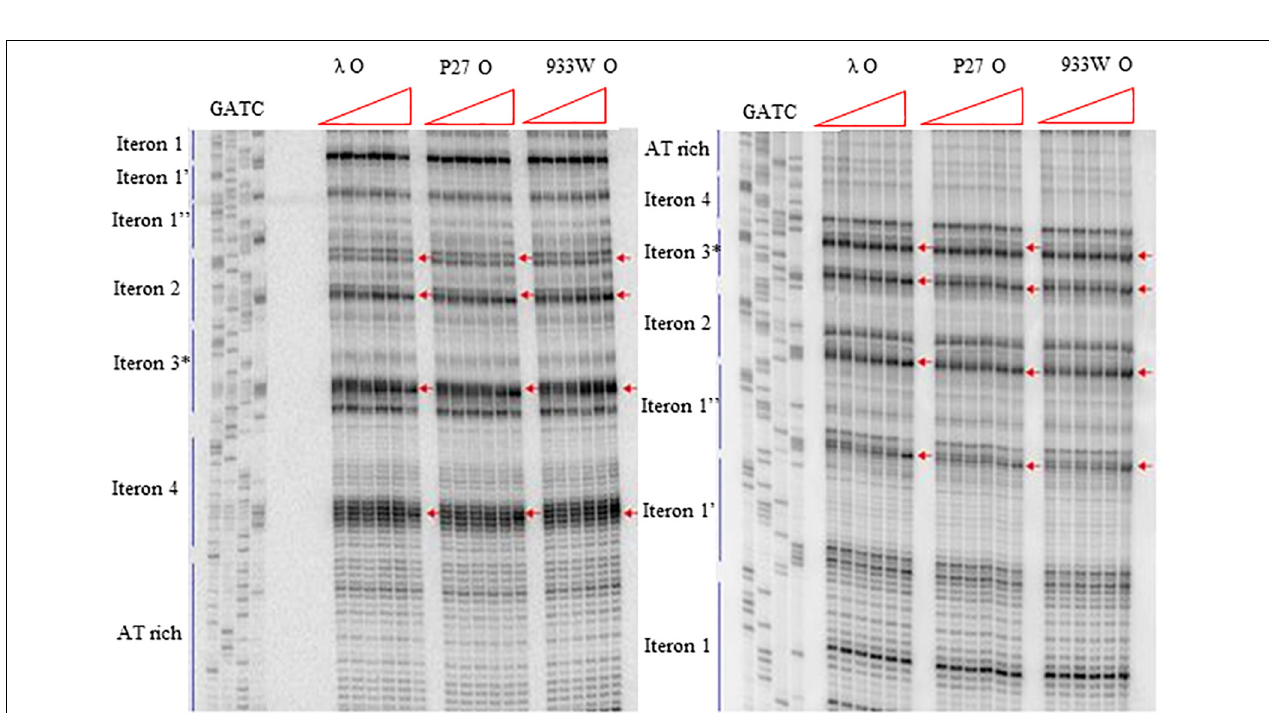
FIGURE 5 | Interactions of O proteins of phages λ , P27 and 933W with DNA templates containing six iterons, as assessed by DMS footprinting. Increasing molar ratios of DNA:O proteins, indicated in particular wells, were as follows: 1:0 (no O protein), 1:2, 1:4, 1:8, 1:16, and 1:32. Arrows indicate major changes (enhancement) in bands’